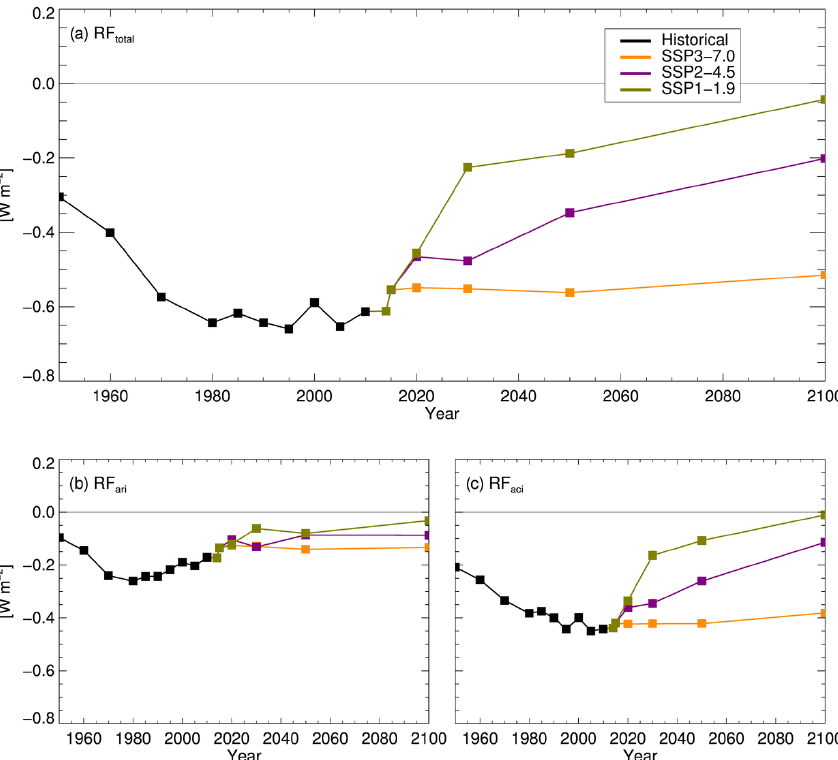
Figure 3. Radiative forcing of anthropogenic aerosol for 1950–2100 relative to 1750: (a) total aerosol RF (RFtotal), (b) aerosol–radiation interactions (RFari), and (c) aerosol–cloud interactions